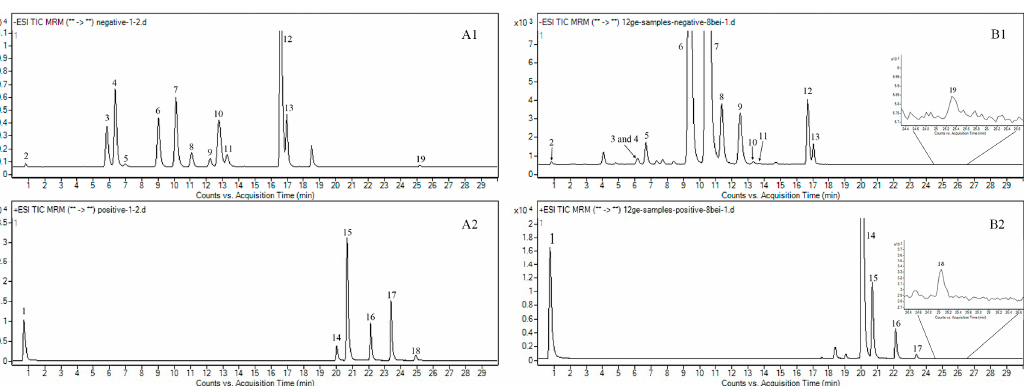
Figure 3. Total ion chromatograms in negative mode of the standard solutions ( A1 ) and WDD sample ( B1 ); total ion chromatograms in positive mode of the standard solutions ( A2 ) and WDD sample ( B2 ).